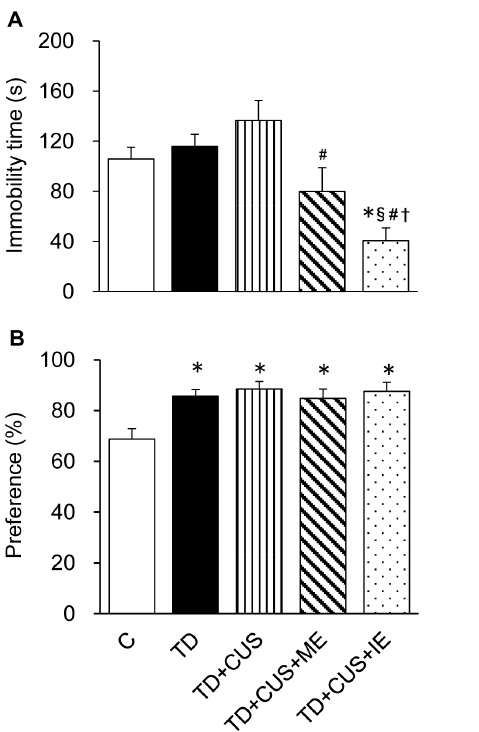
Figure 5. Effects of tryptophan deficiency, CUS and regular exercise on recognition index in object recognition. Data are expressed as mean 6 SEM. *, p , 0.05 vs. C; # , p , 0.05 vs. TD.